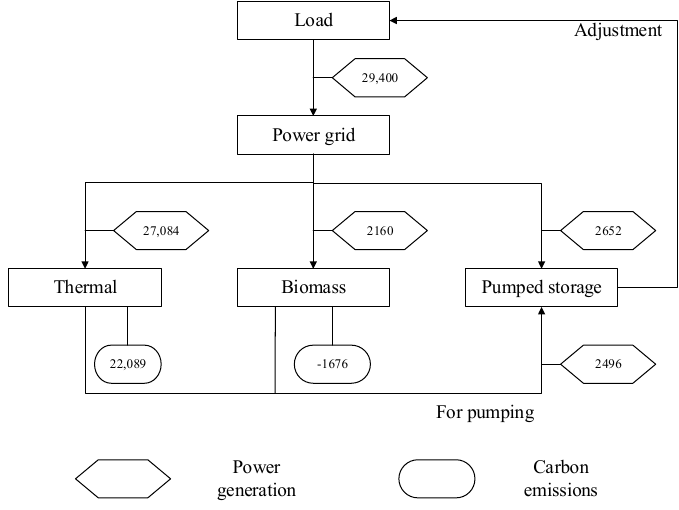
Figure 3. The power generation and carbon emissions flow of CPDS.